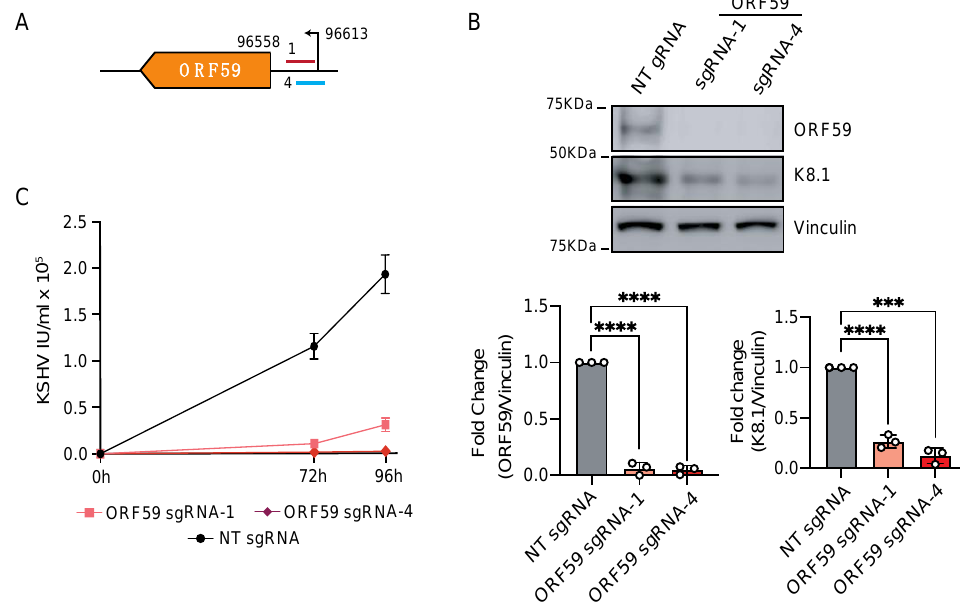
Figure 5. CRISPRi silencing of delayed-early genes in iSLK-219 cells. ( A ) Region of the viral genome encoding ORF59 and position of the sgRNAs. Immunoblot analysis of ( A ) ORF59, and ( B ) K8.1 (in latent and lytic (96 h post-reactivation) in iSLK-219-dC9K cells transduced with a non-targeting (NT) sgRNA or an ORF59-specific sgRNA. Image representative of three biological replicates. Bars: quan- tification of the data. Error bars: standard deviation (one-way ANOVA, **** p < 0.001, *** p < 0.001). ( C ) Quantification of viral titers (IU, infectious units) in the filtered supernatant of iSLK-219-dC9K cells transduced with a non-targeting (NT) sgRNA or ORF59-specific sgRNAs, collected at 72 and 96 h post-reactivation. Error bars: standard deviation.